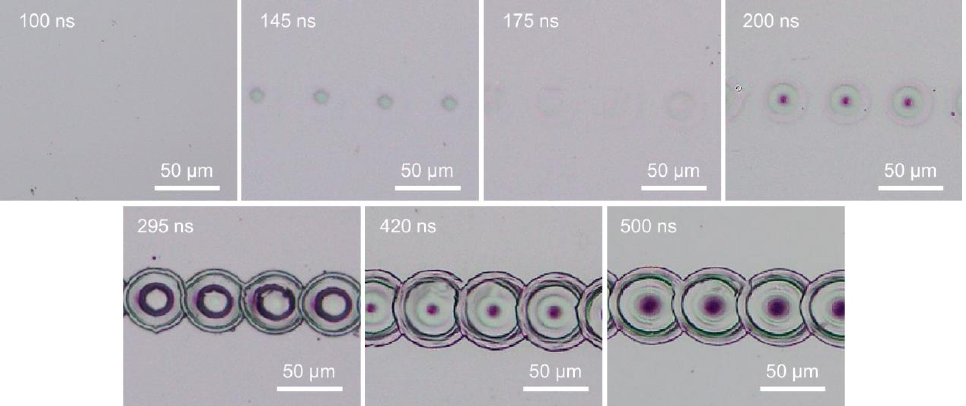
Figure 7. Surface morphologies showing surface melting with increasing pulse width at 4000 mm/s scanning speed. scanning